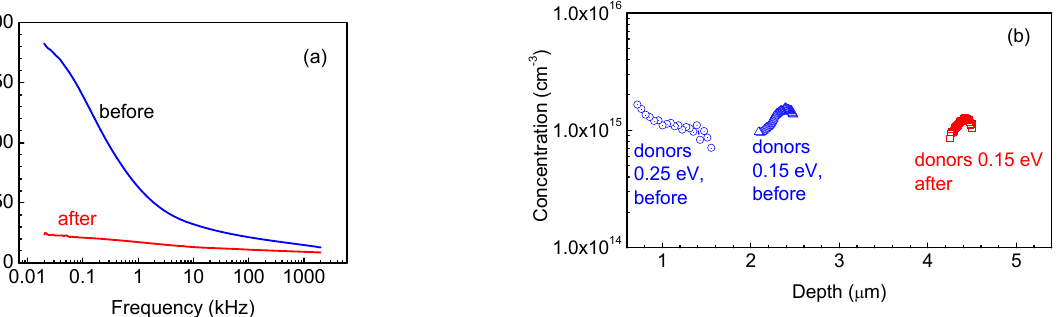
Figure 14. ( a ) C-f characteristics before and after irradiation; ( b ) concentration profiles before and after irradiation.